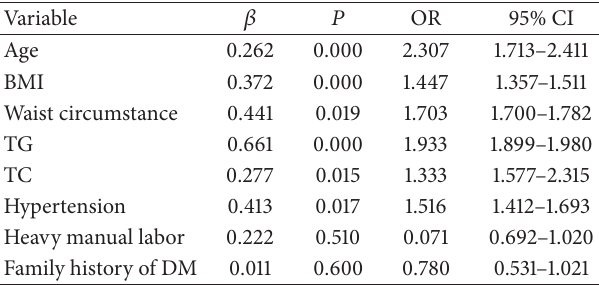
Table 3: Adjusted OR and 95% CI of IGR by associated risk